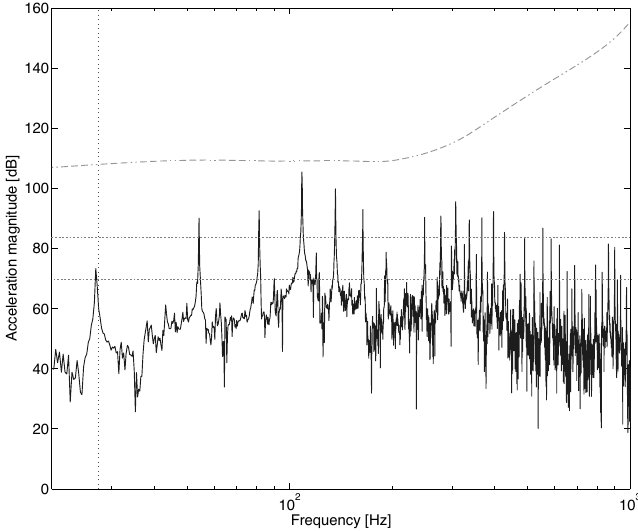
Figure 7. Magnitude spectrum of the vibration signal at the A0 key, recorded on the upright Disklavier playing at MIDI velocity 111. The dash-dotted curve depicts the reference vibrotactile threshold for passive touch [38], while the two horizontal dashed lines represent the minimum and maximum thresholds recently measured under active touch conditions [34]. Picture adapted from